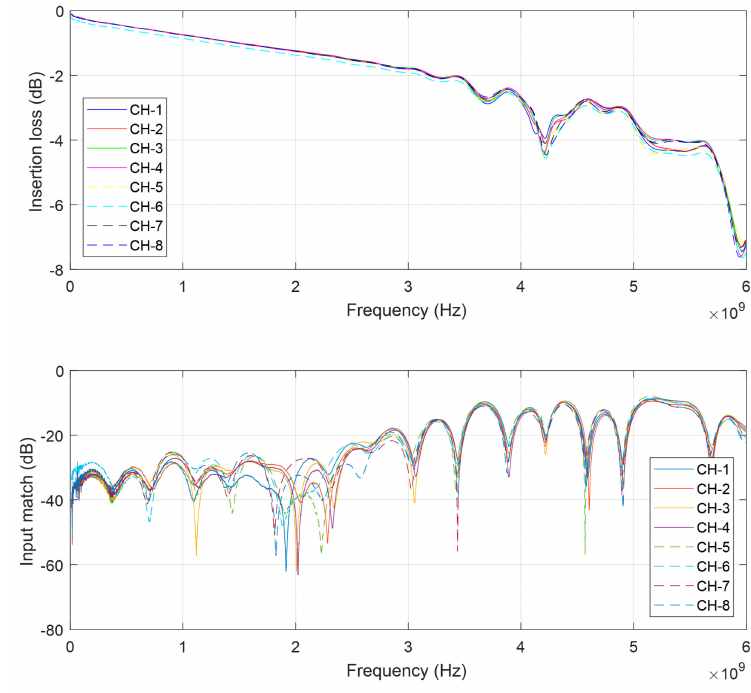
Figure 5. Insertion loss ( top plot ) and input match ( bottom plot ) of the